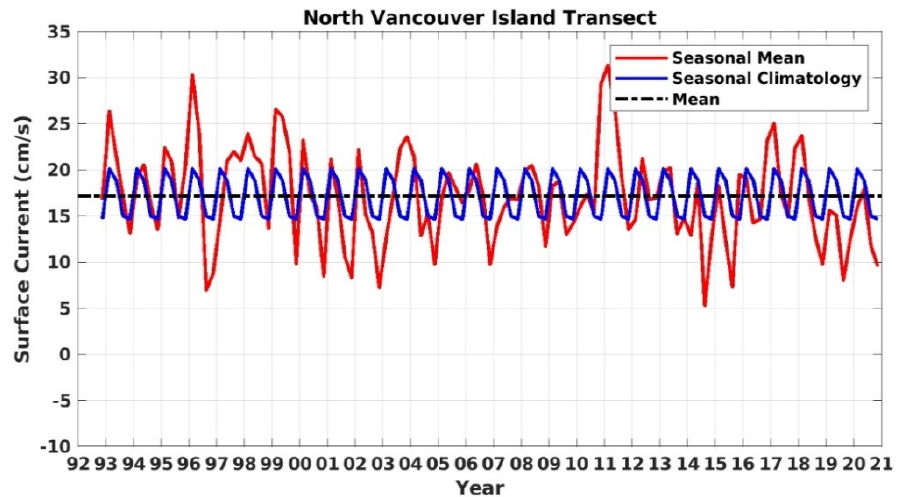
Figure 4. Same as Figure 3 but at the North Vancouver Island Transect.